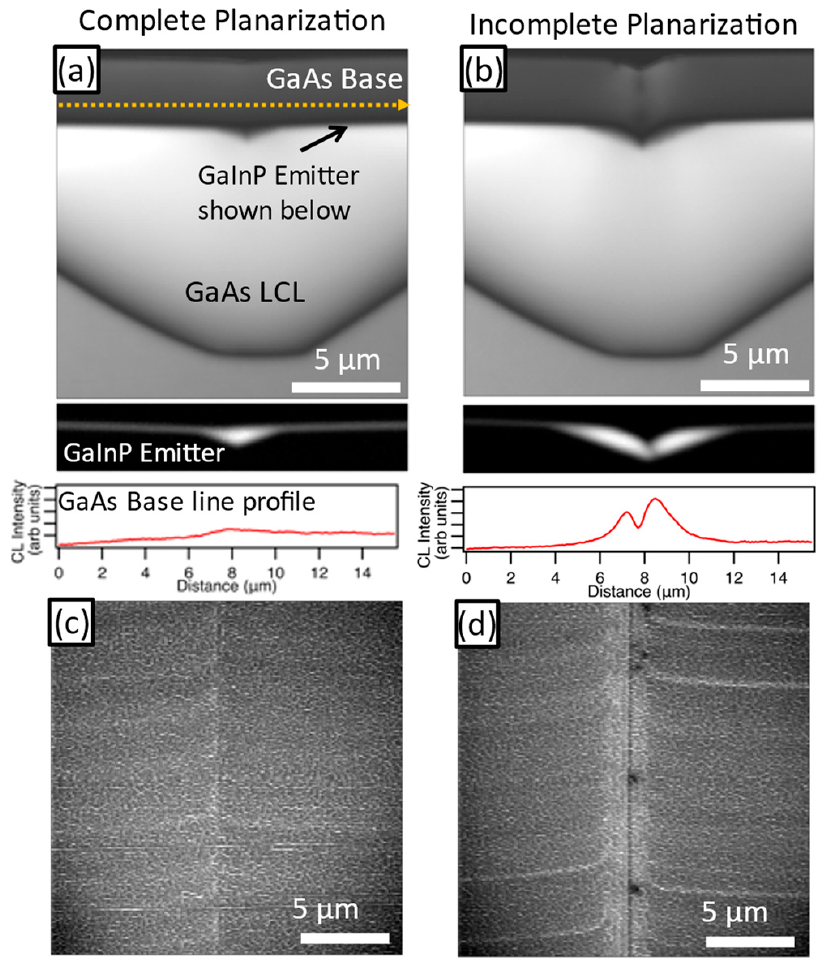
Figure 7. Cross-sectional CL intensity images of ( a ) complete and ( b ) incomplete planarized regions. Horizontal line profiles taken at the approximate location of the arrow are given below each panel.